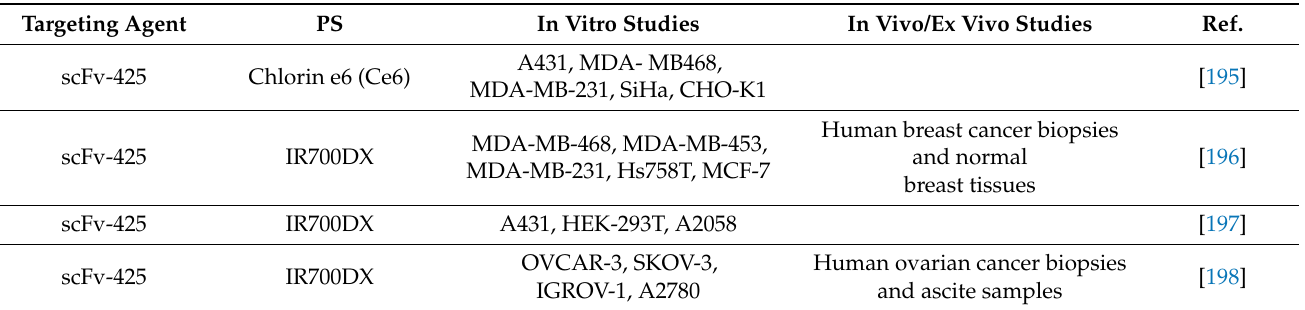
Table 9. EGFR-targeted PDT performed with anti-EGFR